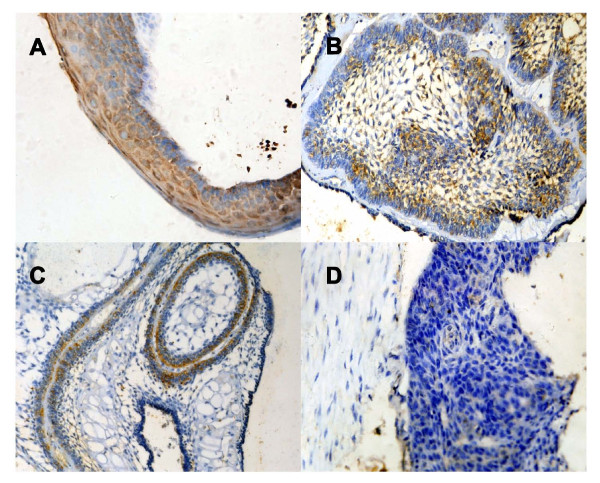
A representative immunohistochemical reactivity for RECK. (A) Keratocystic odontogenic tumor showing strong reactivity (× 400); (B) Follicular ameloblastoma showing strong reactivity in central polyhedral cells and weak in peripheral columnar cells (× 200); (C) Plexiform ameloblastoma showing reactivity in peripheral columnar cells and nearly no expression in central polyhedral cells (× 200); (D) Ameloblastic carcinoma showing no expression in tumor cells (× 400).